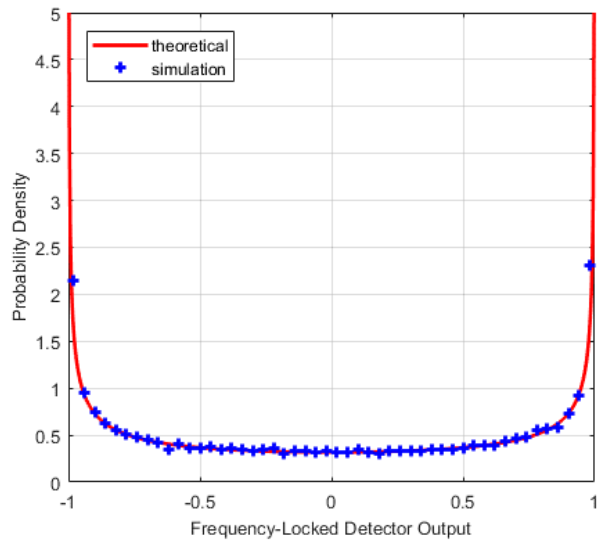
Figure 3. Frequency-locked detector (FLD) output probability density with no signal ( M = 1).